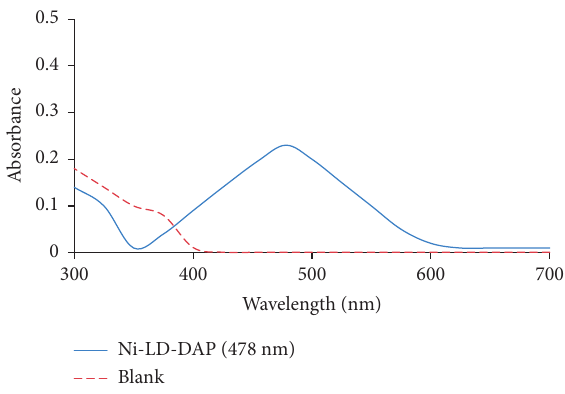
Figure 2: Absorption spectrum at 487nm of LD using the suggested procedure.